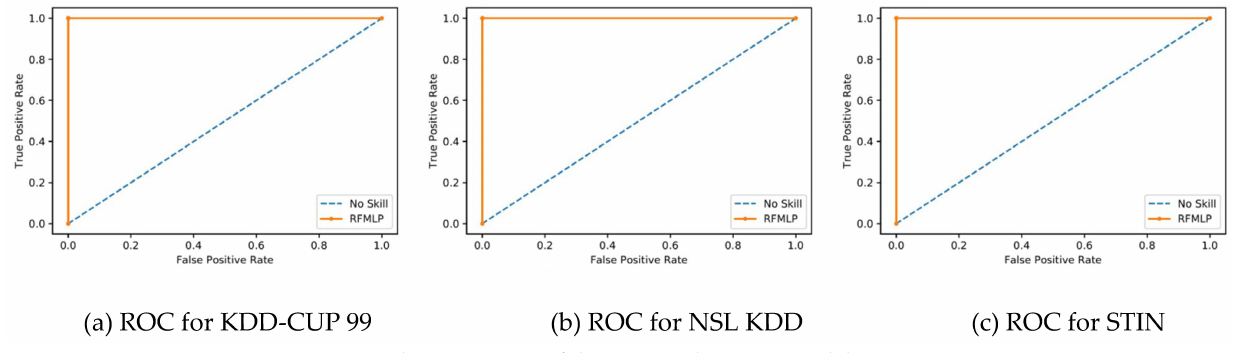
Figure 5. The ROC curve of the proposed RFMLP